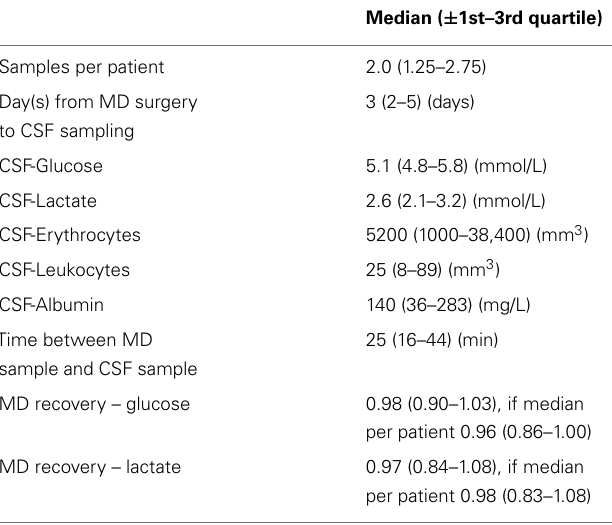
Table of the 29 cerebrospinal fluid (CSF) samples acquired. Presented as average and standard deviation (SD), or median ± 1st–3rd quartile, depending on sample distribution. Samples per patient, days from microdialysis (MD) surgery sam- pling, CSF-glucose (mmol/L), CSF-lactate (mmol/L), CSF-erythrocytes (red blood cell count, RBC, per mm 3 ), CSF-leukocytes (white blood cell count, WBC, per mm 3 ), CSF-albumin (mg/L), time between MD sample and CSF sample